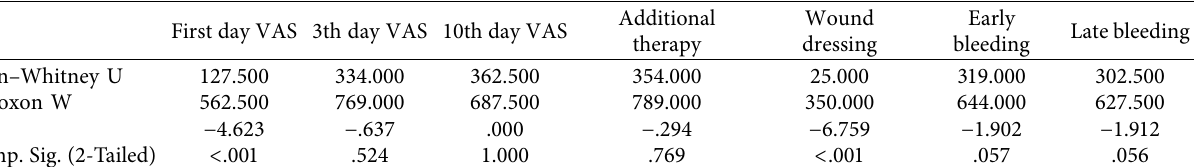
Figure 1: Visual analog scale Table 1: Statistical results.